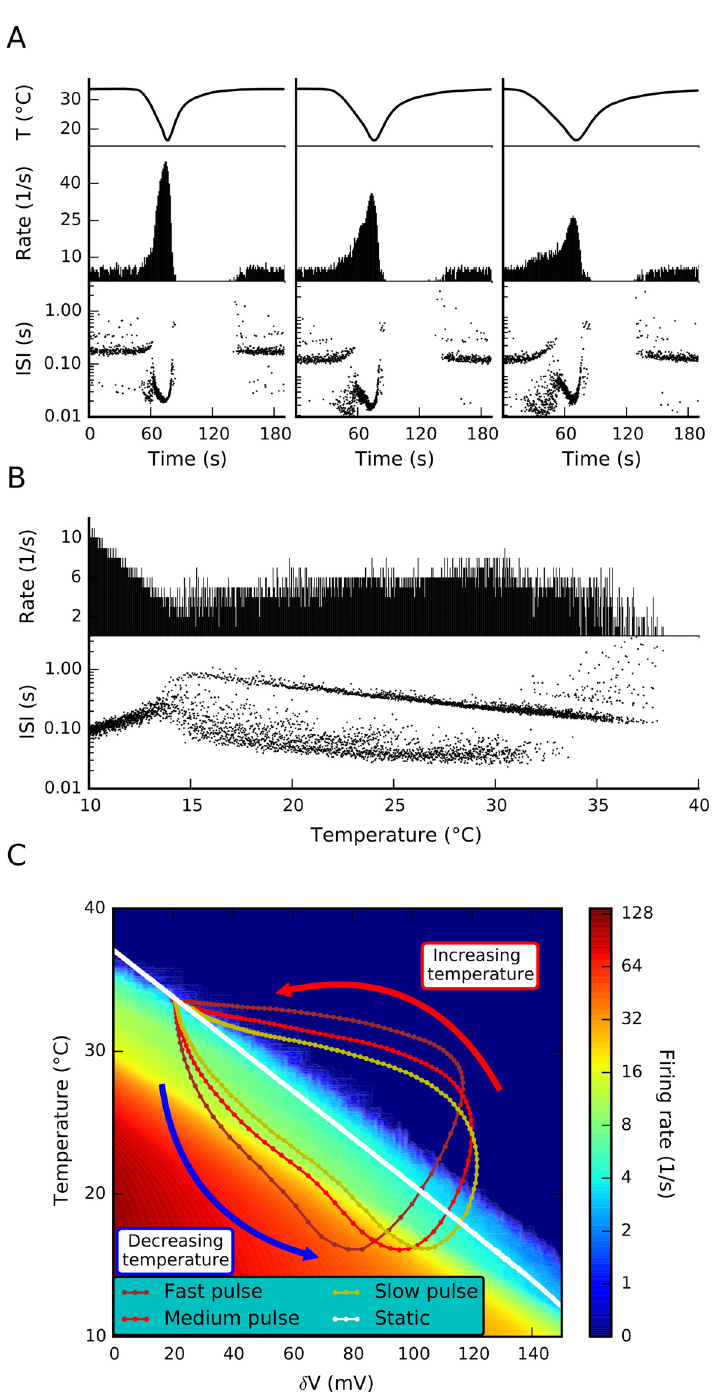
Fig 7. Mechanism of hysteresis in the response to cold. A. Temperature protocol (top), firing rate (middle) and inter spike intervals (bottom) for fast, medium and slow cooling pulses. B. Firing rate and inter-spike intervals during a static response protocol, obtained with a very slow temperature ramp (-0.033°C/s). Also, Ca 2+ and δ V dynamics were accelerated by a factor of 50. C. Firing rate at different degrees of TRPM8 adaptation ( δ V) and temperatures. Color scale represents firing rate in spikes/sec. The colored lines depict the trajectory of δ V and temperature during the protocols shown in A. The white line shows δ V versus temperature for the static (adapted) response